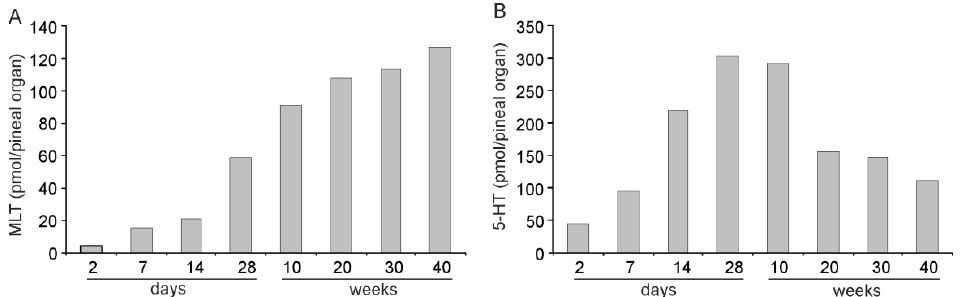
Figure 8. Contents (means) of melatonin, MLT ( A ), and serotonin, 5-HT ( B ), at their peak values in the pineal organs of turkeys at the ages of 2, 7, 14, 28 days and 10, 20, 30, 45